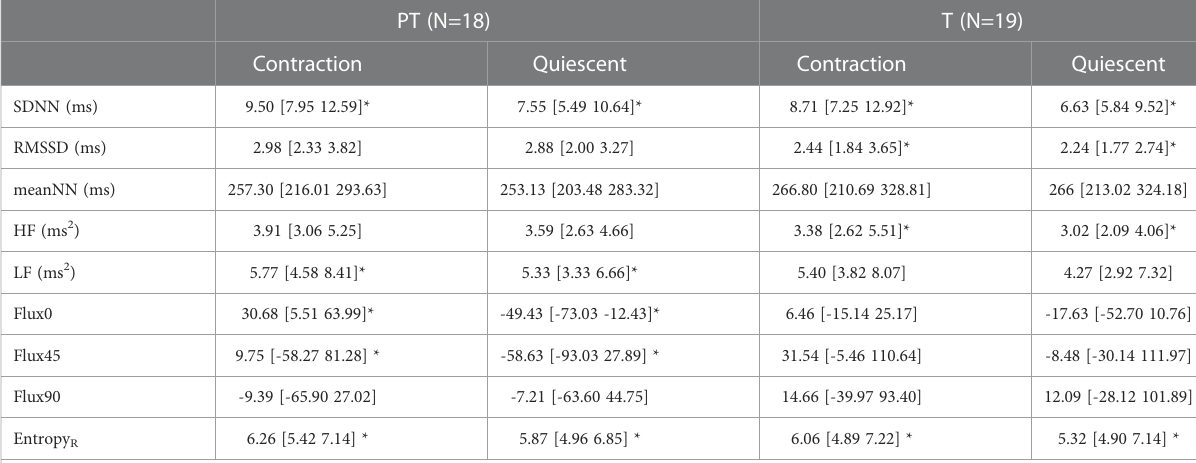
TABLE 3 Values of linear, nonlinear, and time-frequency indices of ultra-short-term fetal heart rate variability (FHRV) during average contraction and quiescent periods for Term (T) and Preterm (PT) groups.